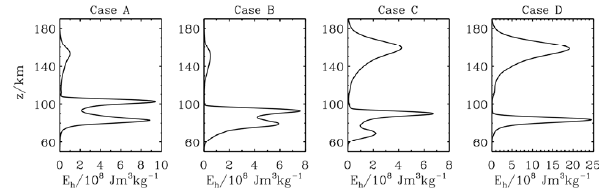
Fig. 6. E h at 15h for cases A, C, and D, and at 16.5h for case B. E at 15 hr for cases A, C, and D, and at 16.5 hr for case B. 714 Figure 6. h case D. For case B, at 16.5 h, the first/second critical layer